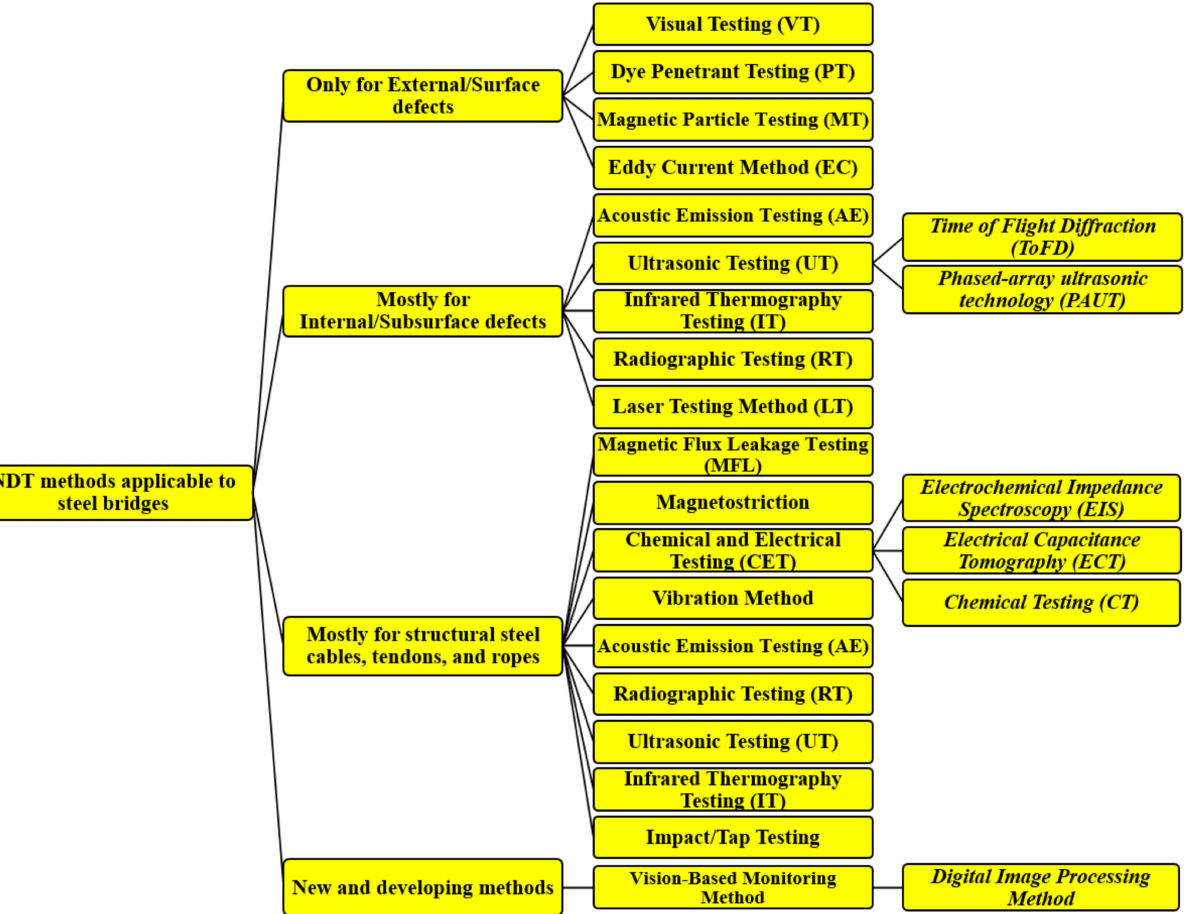
Figure 2. NDT methods applicable to steel